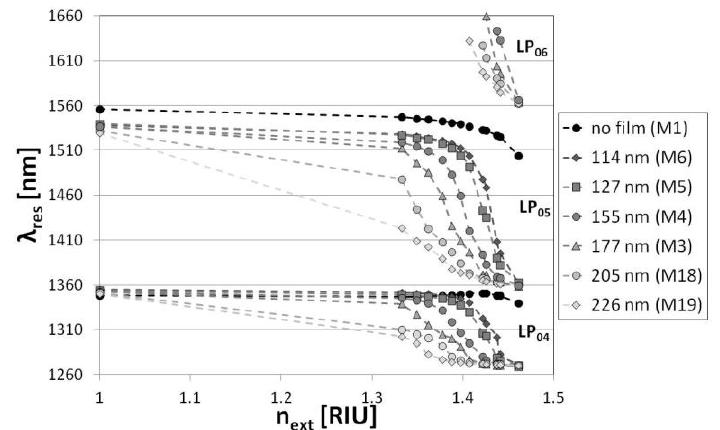
is given at λ = 589 ext